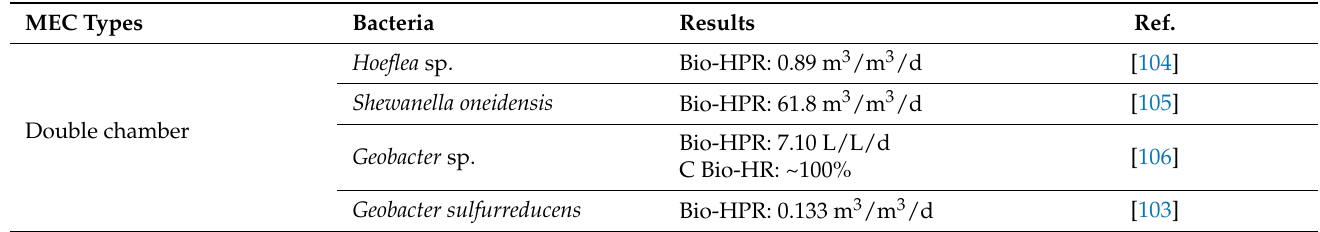
Table 7. Effect of bacteria on performance of